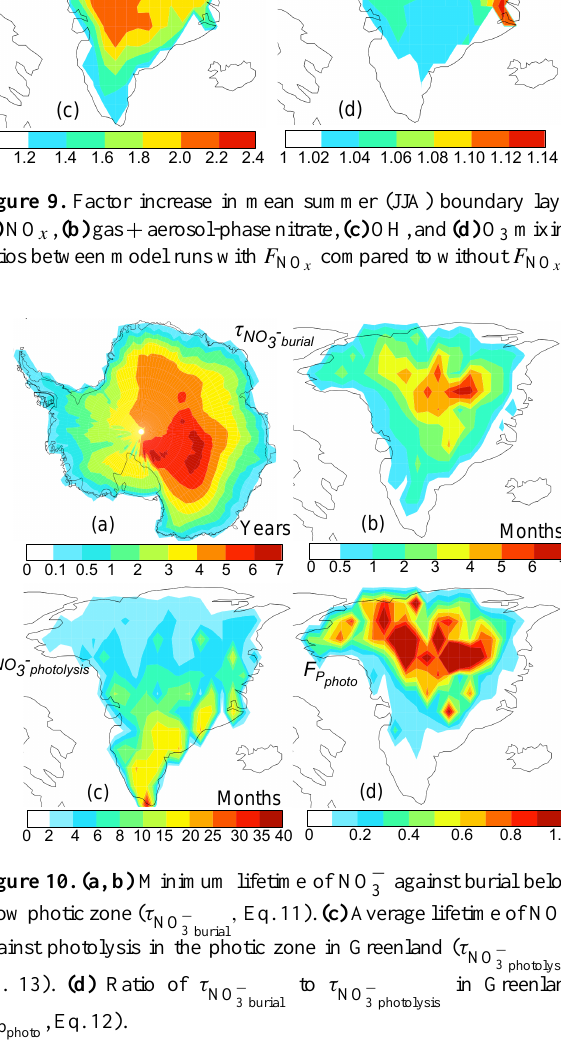
Figure 10. (a, b) Minimum lifetime of NO − against burial below 3 , Eq. 11). (c) Average lifetime of NO − snow photic zone ( τ NO − 3 3 burial against photolysis in the photic zone in Greenland ( τ , NO − 3 photolysis Eq. 13). (d) Ratio of τ to τ in Greenland NO − 3 NO − 3 burial photolysis ( F p , Eq. photo